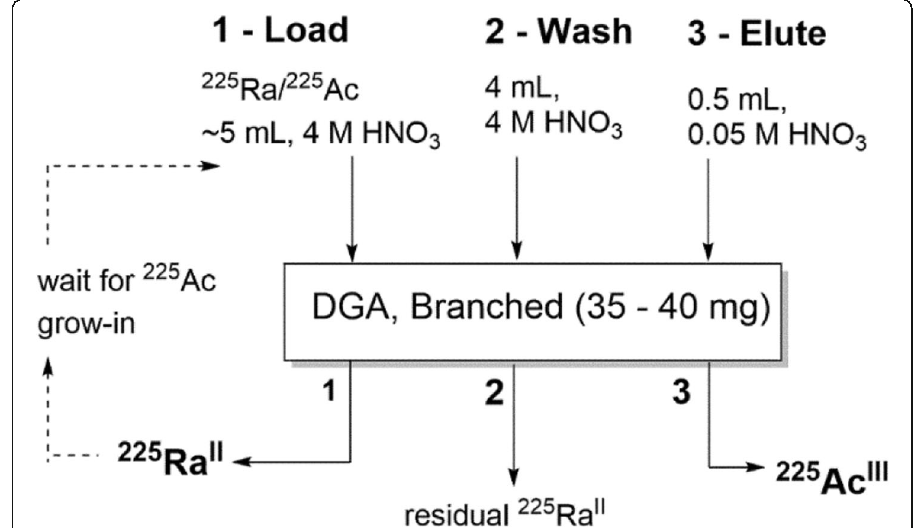
Fig. 2 225 Ra/ 225 Ac radiochemical separation method used for purification of ISOL-produced 225 Ac. The solution resulting from etching 225 Ra and 225 Ac from the aluminum target was diluted with nitric acid (to